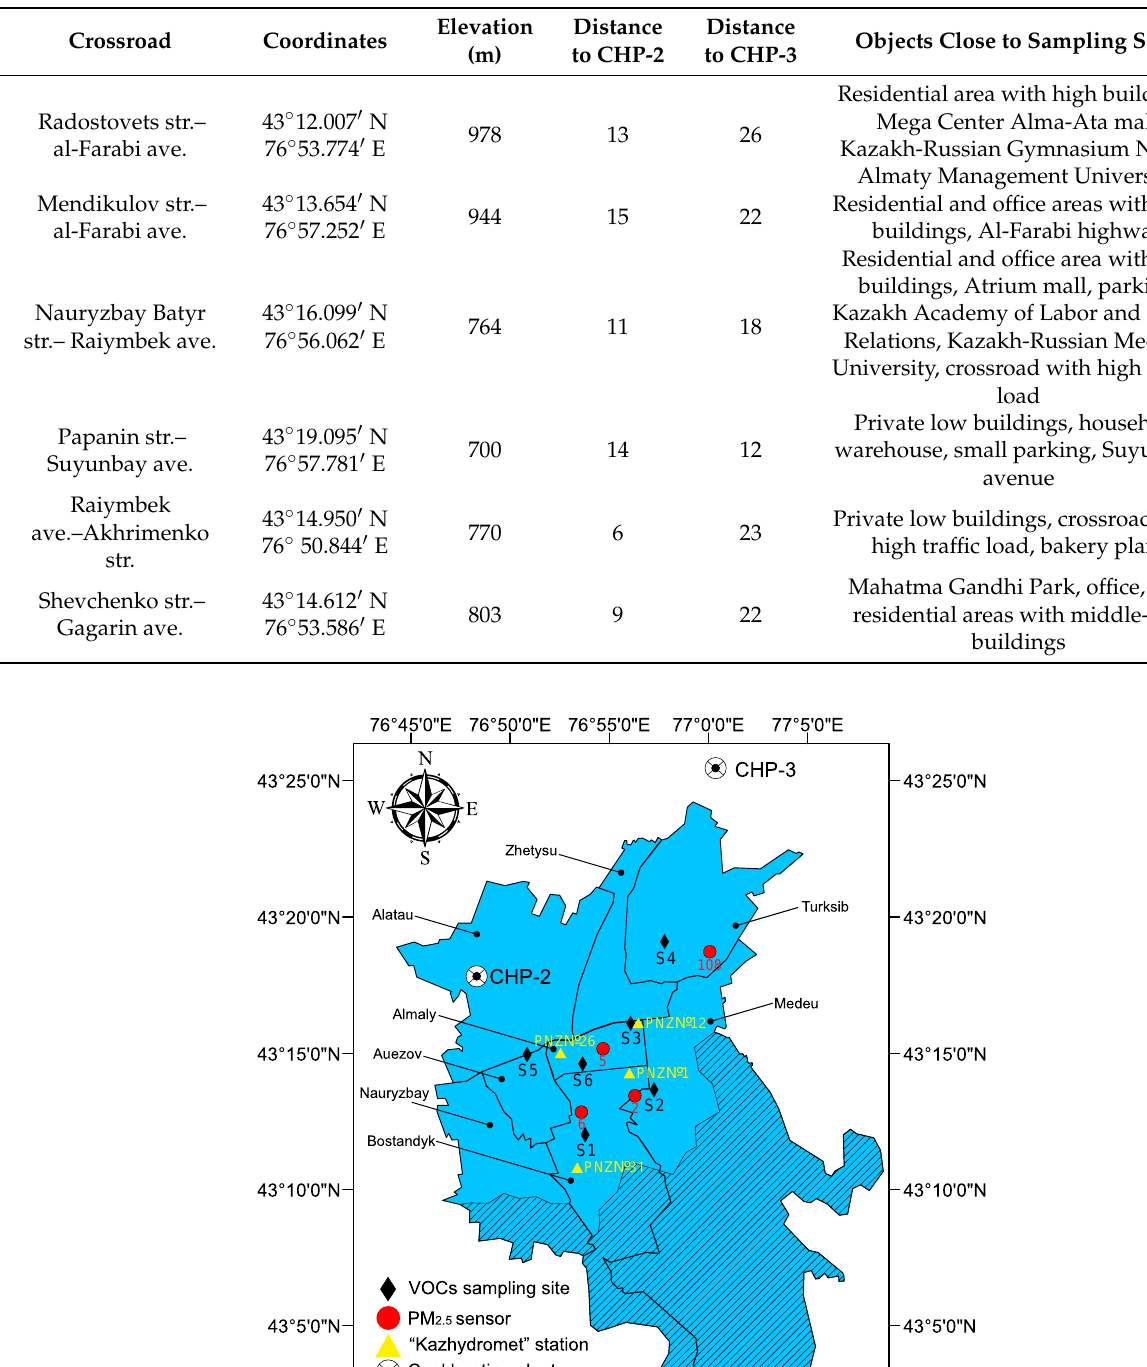
Table 1. VOCs sampling sites.